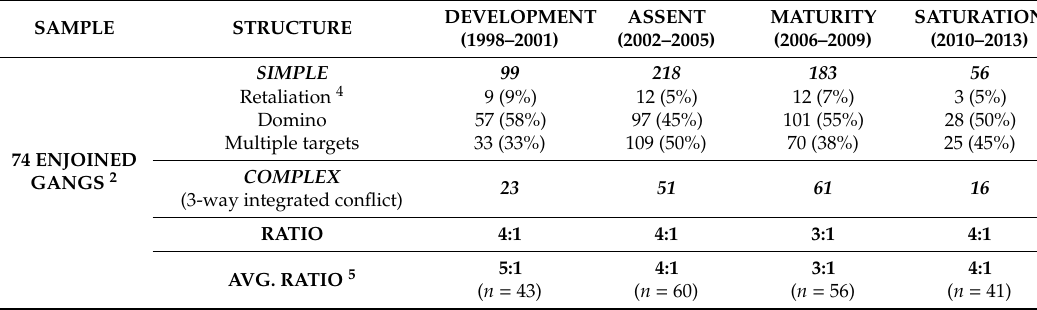
Table 3. Triad Census Comparing Egonet Structure of Enjoined Gangs to Focal Alter Gangs 1